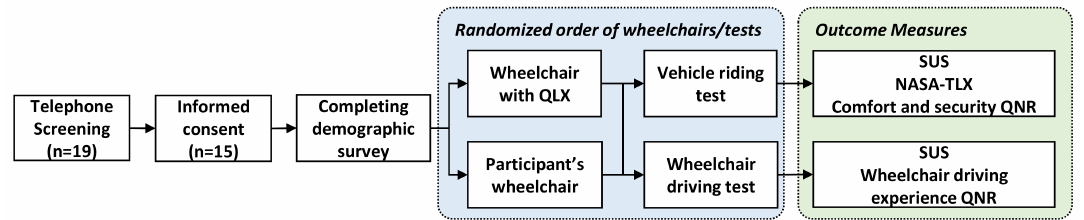
Figure 6. A flowchart for the wheelchair driving and vehicle riding tests